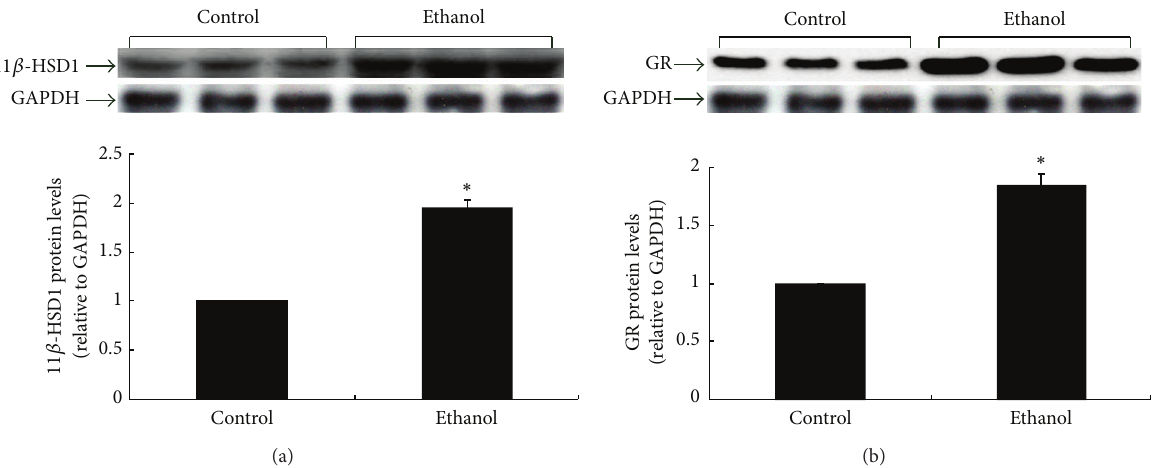
Figure 2: 11 𝛽 -HSD1 and GR proteins in the liver of control and ethanol rats after 3 months of ethanol intake (8g ⋅ kg −1 ⋅ d −1 ). Protein levels are expressed relative to the control and shown as the mean ± SEM ( 𝑛 = 6 ). ∗ 𝑃 < 0.05 ethanol versus control.